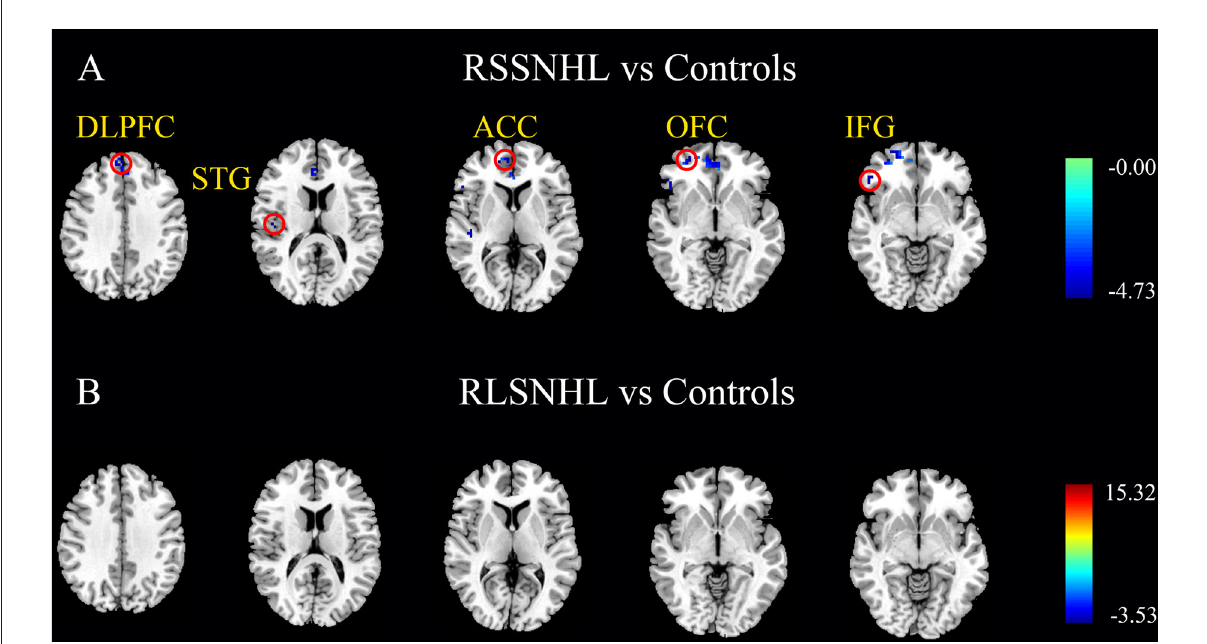
FIGURE2 Effective connectivity from cerebellum lobule V among RSSNHL, RLSNHL, and Controls. (A) Significant regions between RSSNHL and Controls. (B) No significance between RLSNHL and Controls. The significant p was set at < 0.05 with family-wise error correction. The region with the significant difference among the three groups is shown with color. OFC, middle orbitofrontal cortex; IFG, inferior frontal gyrus; ACC, anterior cingulate cortex; STG, superior temporal gyrus; DLPFC, dorsal lateral prefrontal cortex; RSSNHL, right sudden sensorineural hearing loss; RLSNHL, right long-term sensorineural hearing loss.